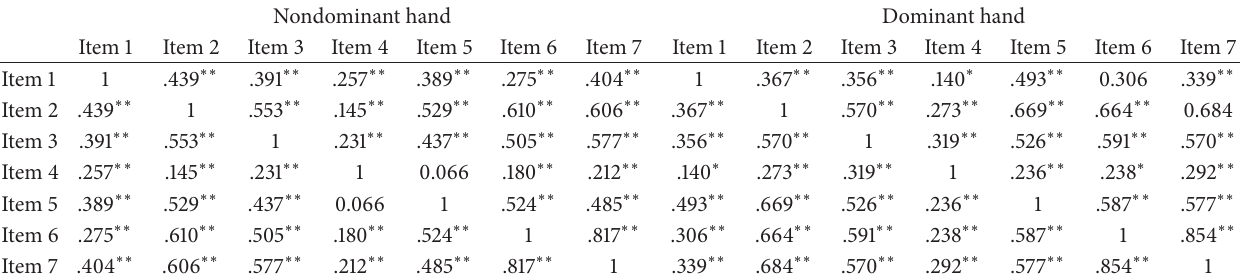
Table 3: Pearson’s correlation for internal consistency.